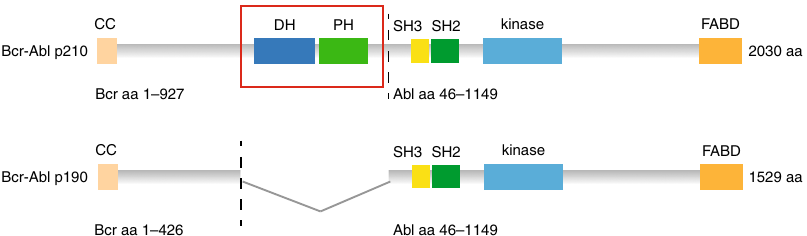
Fig. 1 Domain organization of Bcr-Abl. The two isoforms of the fusion protein Bcr-Abl, p210, and p190, are shown with their sizes and domain arrangement. The breakpoint between Bcr and Abl is indicated with a dotted line. CC coiled-coil, DH Dbl-homology, PH Pleckstrin-homology, SH3/SH2 Src-homology 3/2, FABD F-actin binding